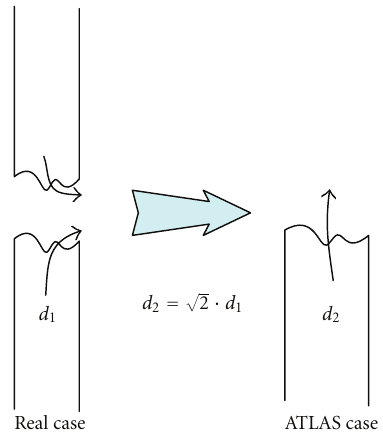
Figure 23: Simulation concept of the guillotine break of a SG U- tube.